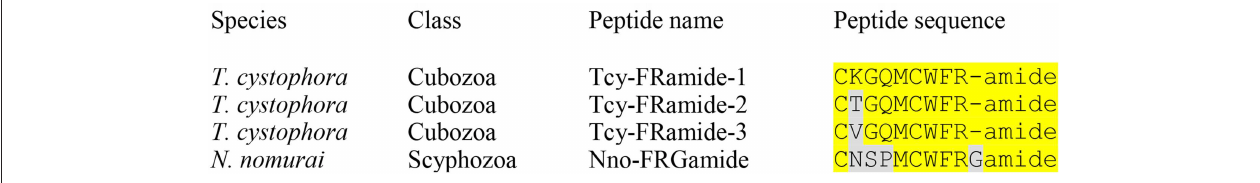
have peptides that are very similar to the ones occurring in